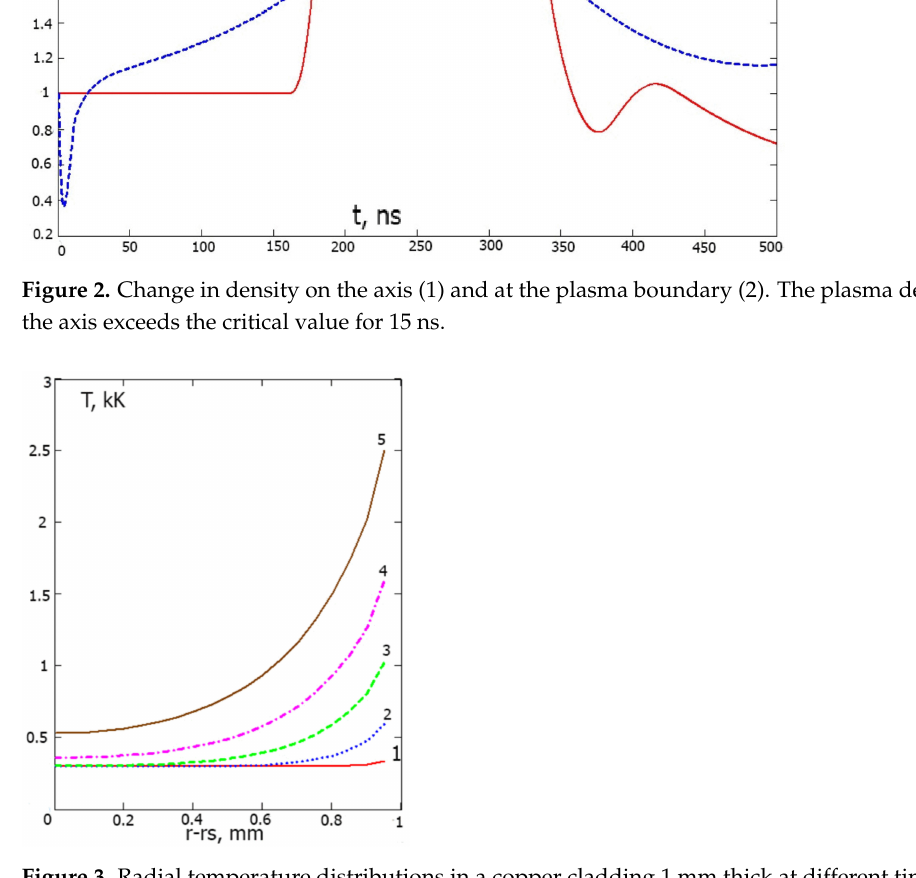
Figure 3. Radial temperature distributions in a copper cladding 1 mm thick at different times; t , ns: